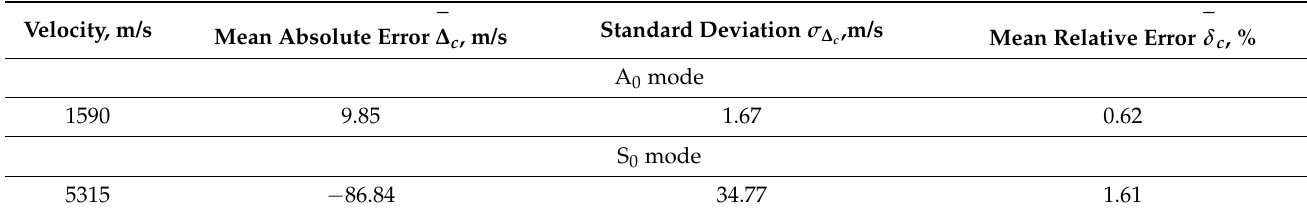
Table 3. The metrological characteristics of the velocity ( f = 160 kHz) dispersion curve for the A 0 and S 0